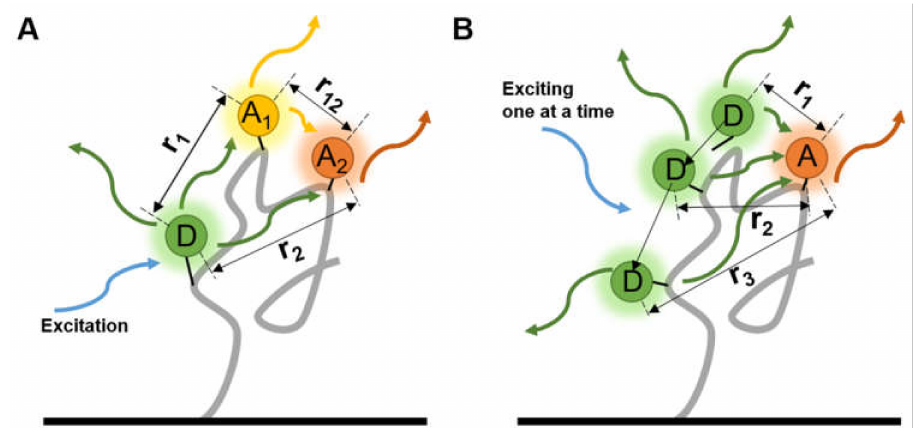
Figure 4. Two types of multi-labeled smFRET. Each molecule was labeled by ( A ) one donor and two different accepters at the same time, or ( B ) altering the loci of donor, to measure the distances among three or more